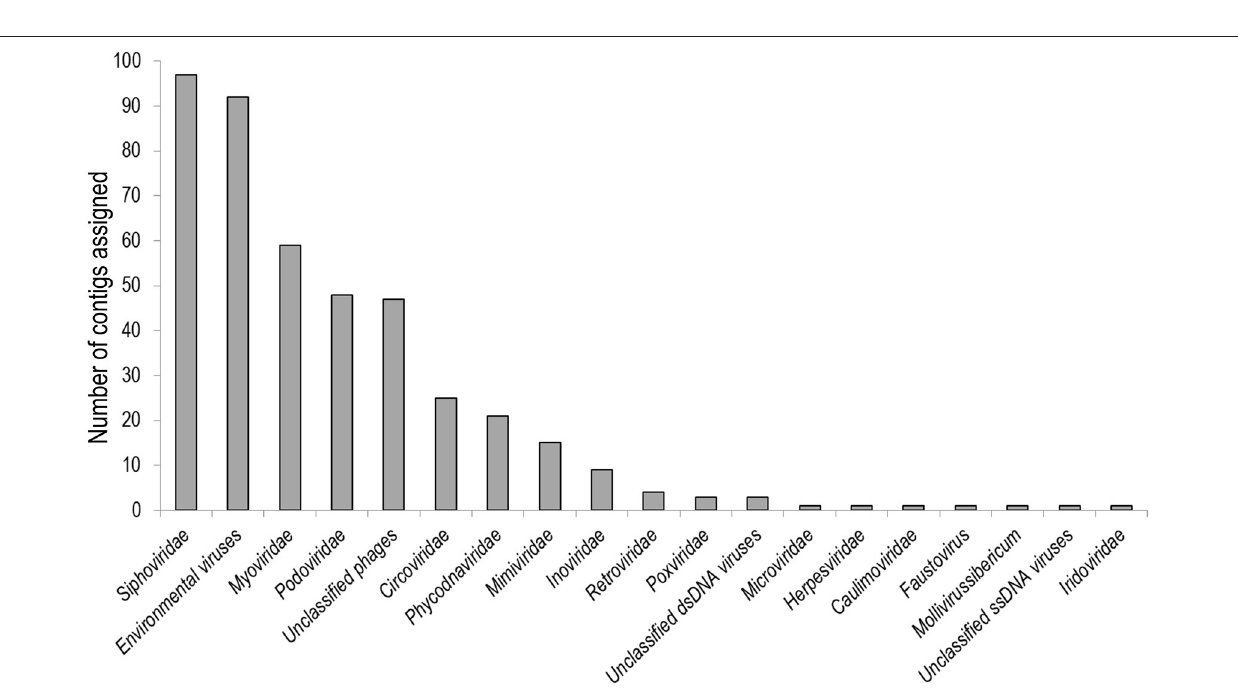
1,008 bp) suggesting three genotypes, which we refer to from hereon as A-C. There were three contig configurations of the circovirus sequences: Type-A (8 contigs), Type-B (2 contigs)